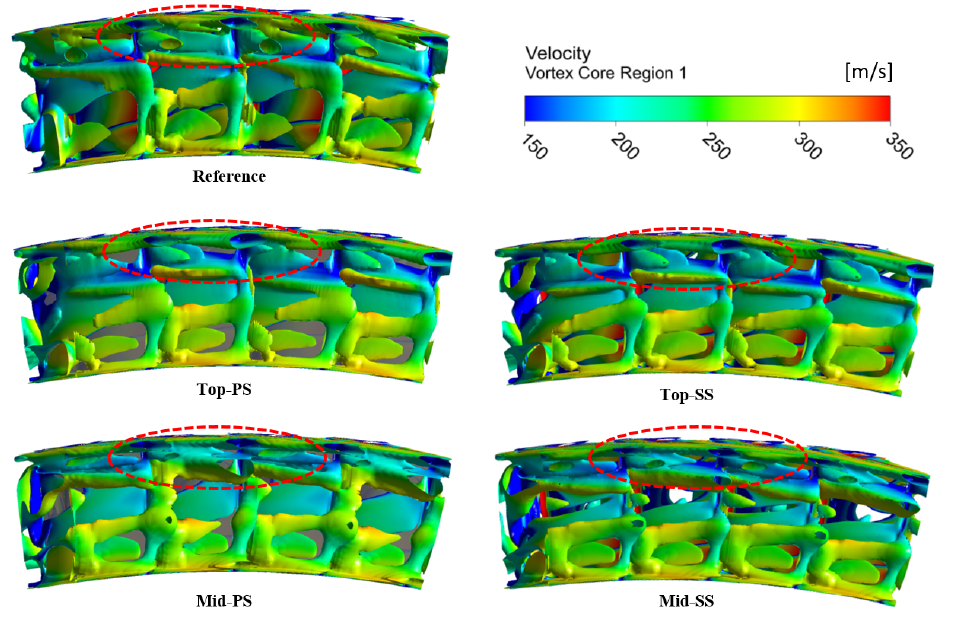
Figure 9. 3-D vortex structure at outlet of the R 1 blade.